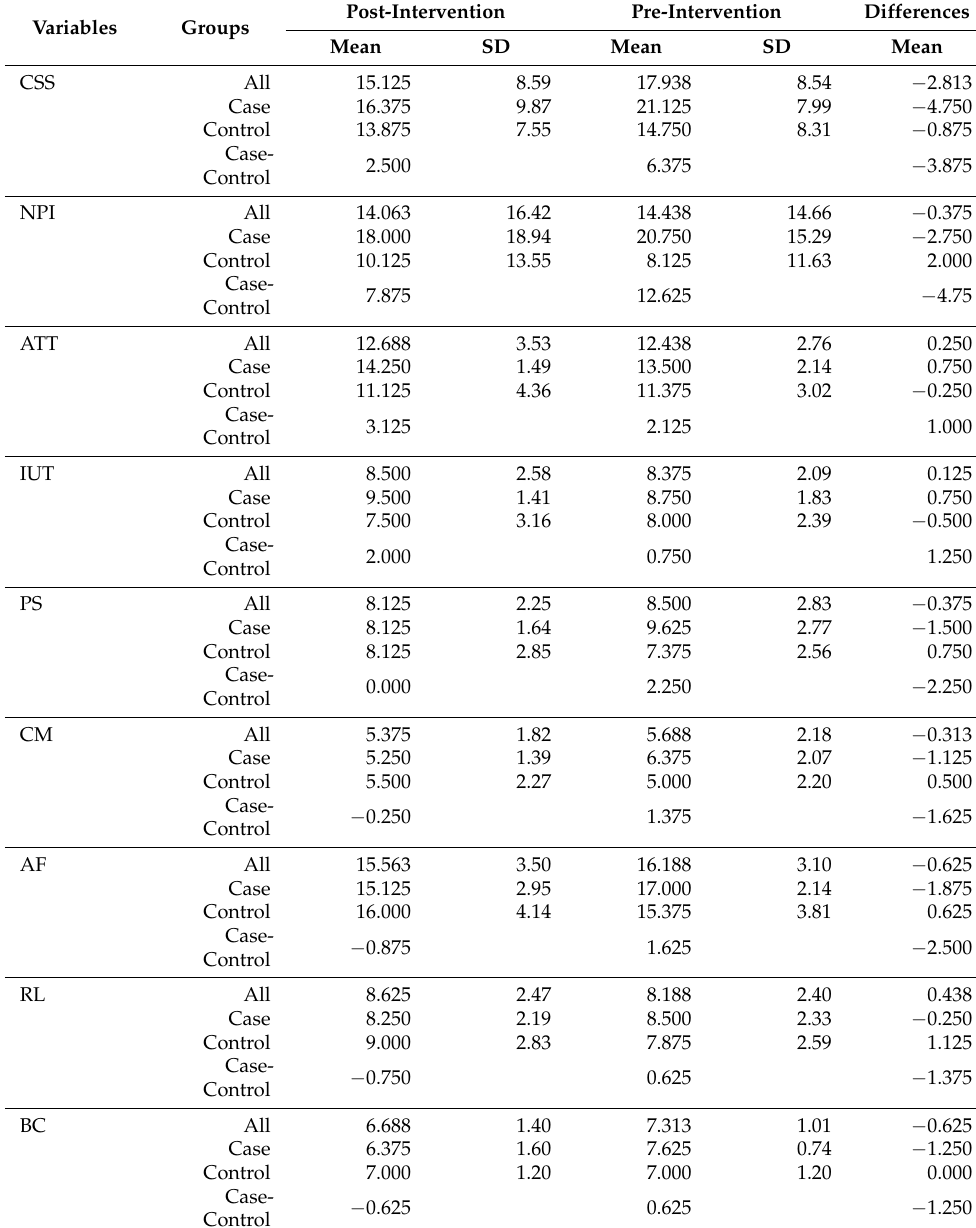
Table 3. Descriptive statistics for the difference-in-differences of the target variables. Post-Intervention Variables Groups